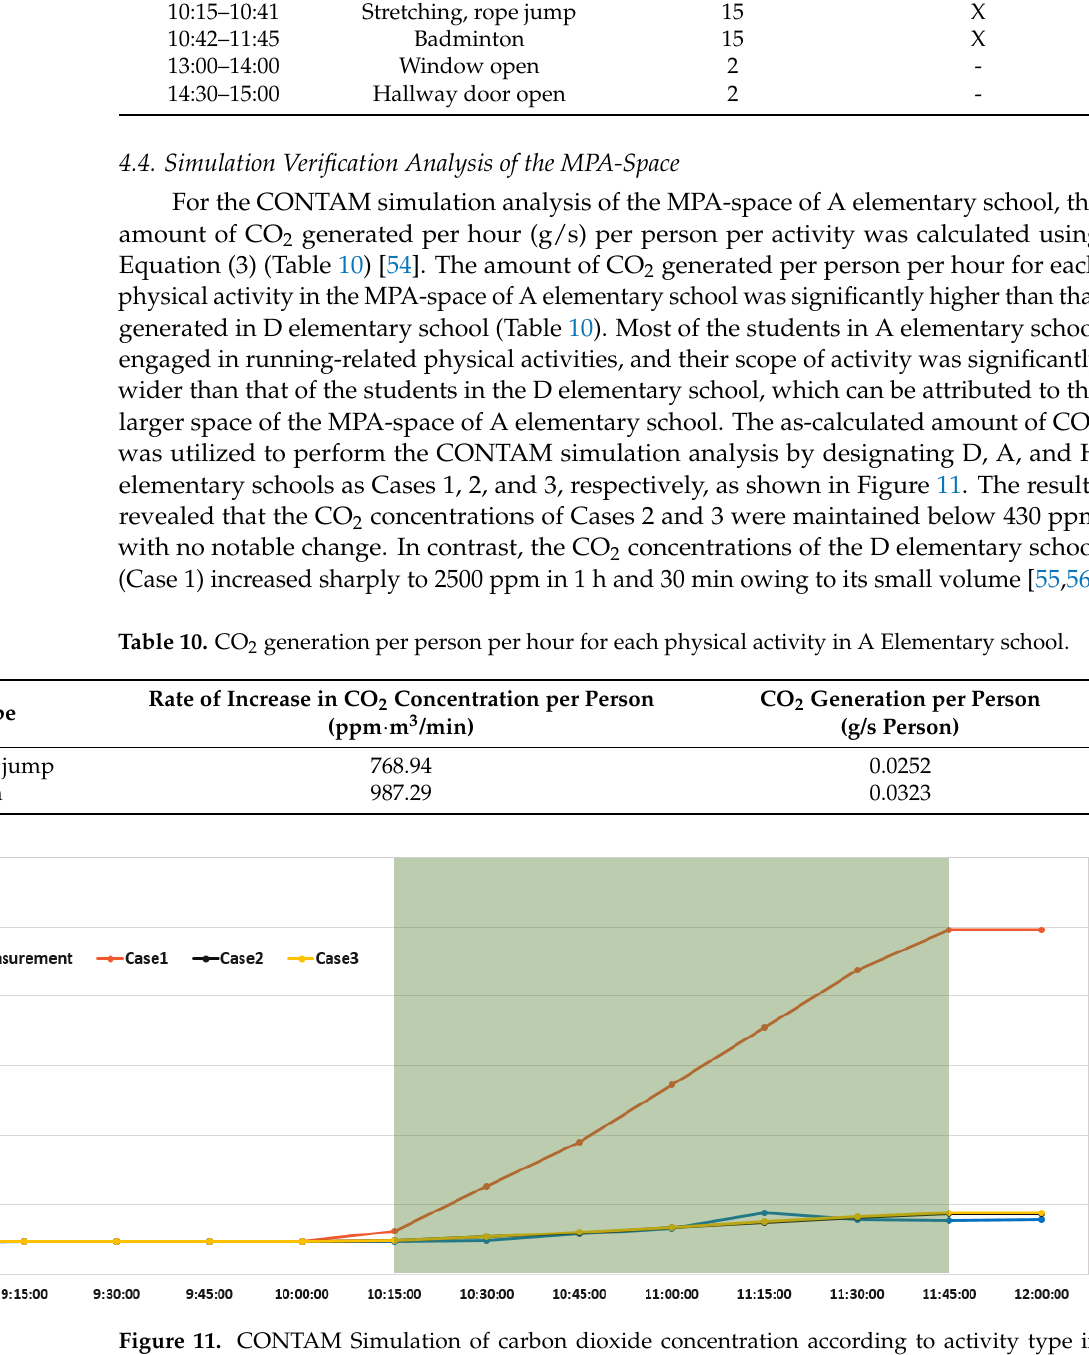
Figure 11. CONTAM Simulation of carbon dioxide concentration according to activity type in MPA- space in A elementary school. MPA-space in A elementary